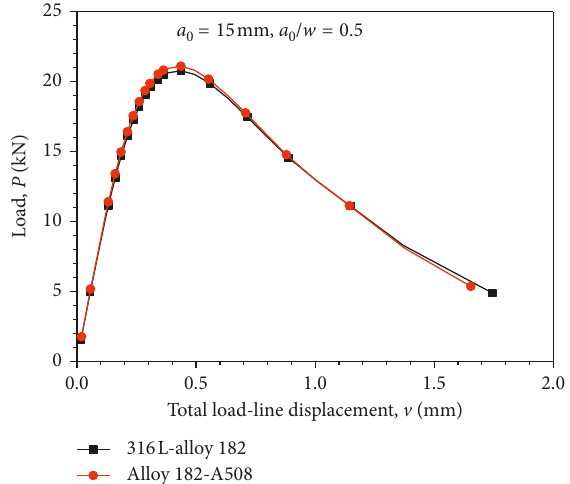
Figure 13: Load-applied displacement curve at different interfaces of DMW